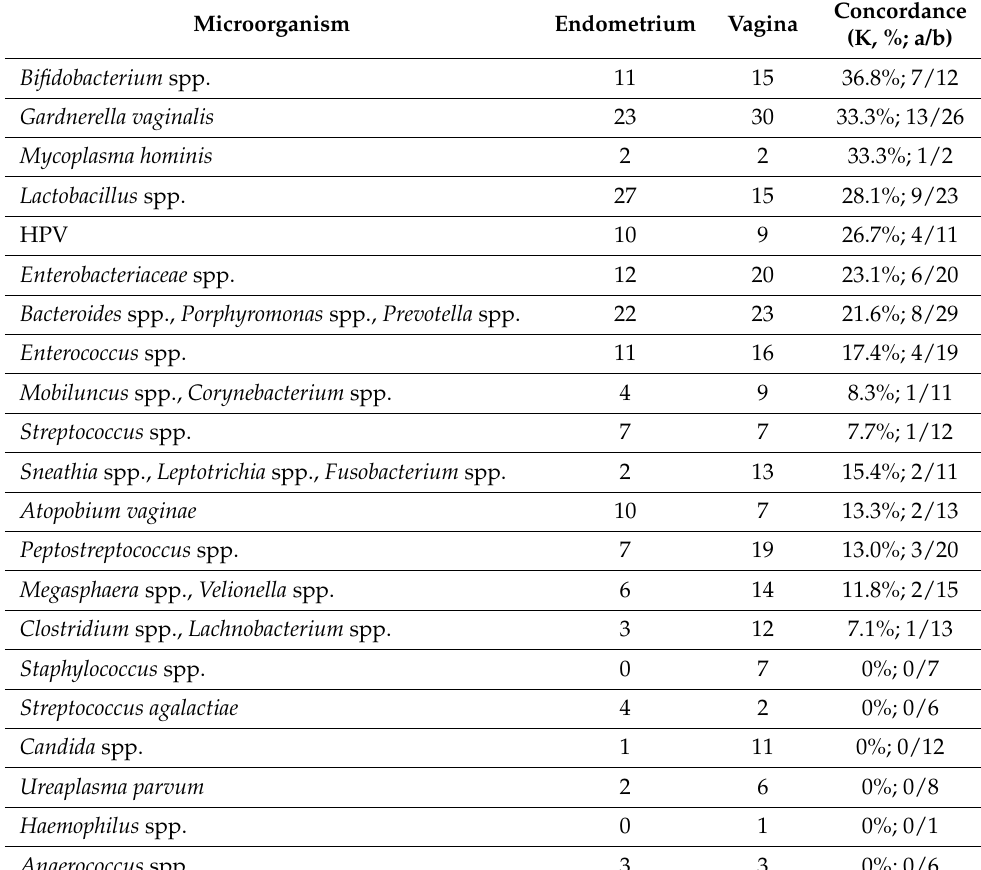
Table 1. Microbial concordance in the endometrium and in the vagina.